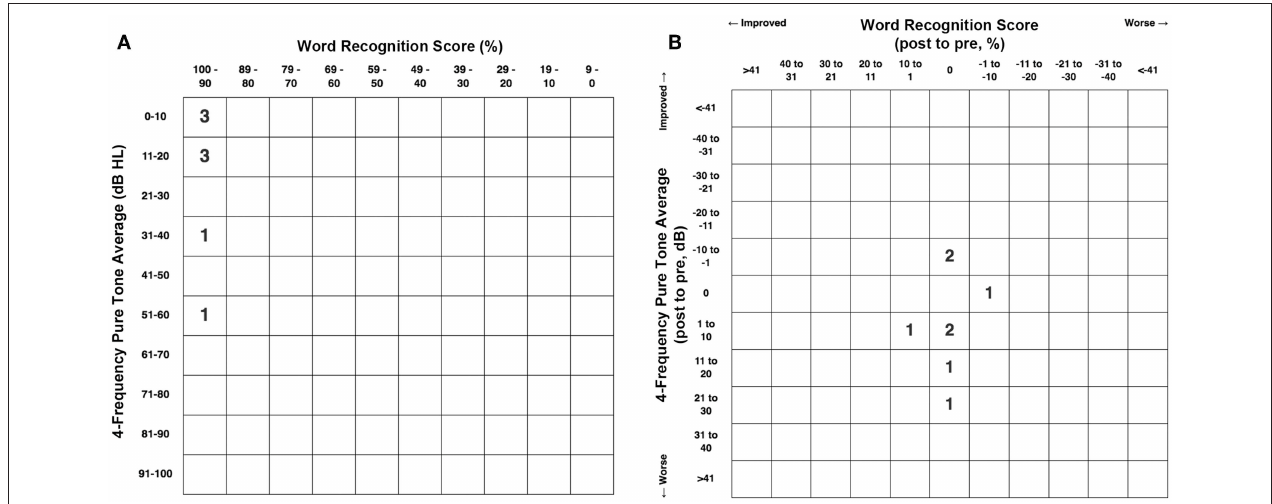
FIGURE 6 | (A) Pretreatment scattergram of the 4-frequency air-conduction pure tone average audiometric data for the 8 patients who underwent RWR for management of their CFD ( n = 8, Group 1). One subject ( Table 1 , Group 1 Patient 2) had a true conductive hearing loss with a pretreatment 4-frequency air-conduction pure tone average of 56.25 dB in his right ear; which had the CFD (see Figure 2 ). (B) Post-treatment scattergram of the audiometric data for 8 patients who underwent RWR for management of CFD. Six ears had no change in word recognition score (WRS), including the 1 ear with a true conductive hearing loss and CFD (Patient 2). One had an improvement of speech discrimination ability from 96 to 100%, while another had a decrease in speech discrimination from 96 to 92%. Including the ear of Patient 2 with the conductive hearing loss and CFD, the mean pre-operative air-conduction 4-frequency pure tone average was 19.7 dB (range 5–56.25 dB), while the mean post-operative air-conduction 4-frequency pure tone average was 22.8 dB (range 5–51.25 dB). As shown in the scatterplot (B) , 5 ears had worsening of the 4-frequency air-conduction pure tone average; while 3 stayed the same or improved post-operatively. There was no statistically significant difference in the 4-frequency air-conduction pure tone average pretreatment compared to post-treatment (paired t -test, p = 0.472). Six ears had no change in WRS, including the 1 ear with a true conductive hearing loss and CFD (Patient 2). One patient had an improved WRS (96–100%) and one patient had a worsened WRS (96–92%). There was no statistically significant difference in the WRS pretreatment compared to post-treatment (paired t -test, p = 0.402). Copyright © P.A. Wackym, used with